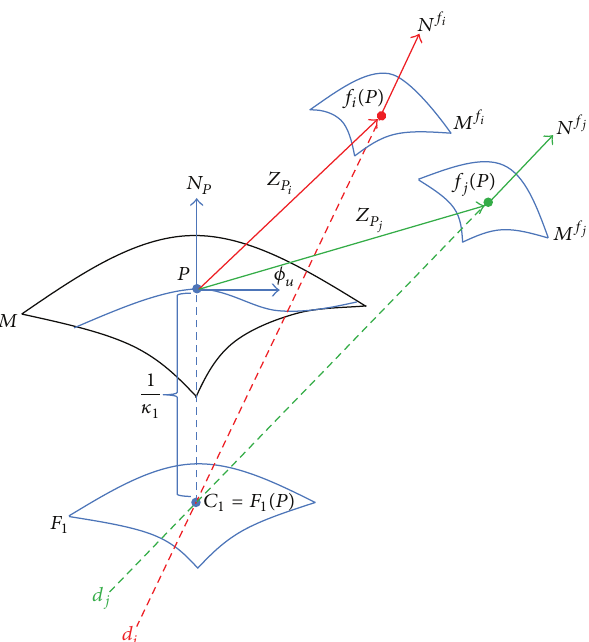
Figure 1: Directions of normals of all surfaces at a constant distance from the edge of regression on 𝑀 that formed along directions of 𝑍 𝑃 lying in plane 𝑆𝑝{𝜙 𝑢 , 𝑁} and their intersection point (focal